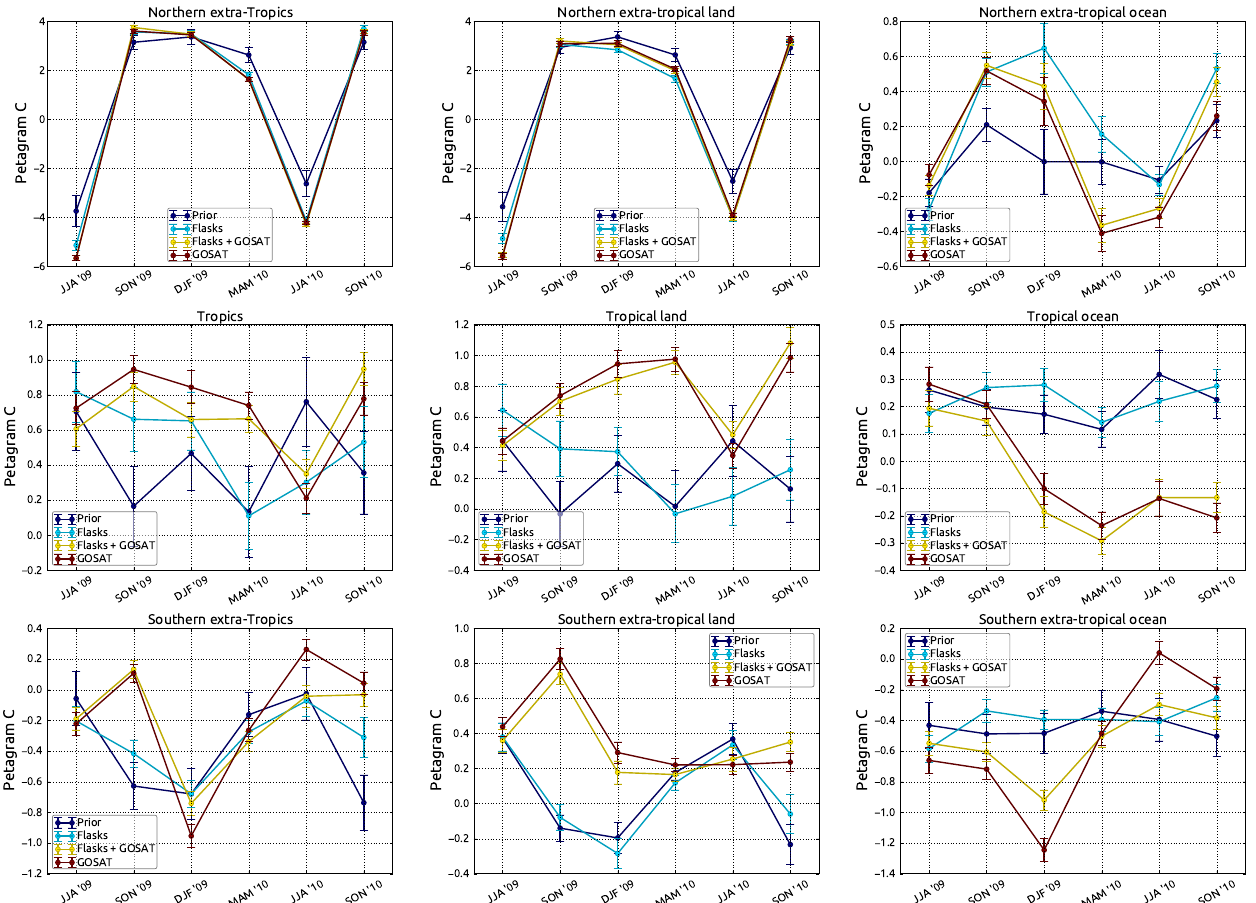
Fig. 10. Seasonal time series of the surface flux from the northern extra-tropics (top row), the tropics (middle row), and the southern extra- tropics (bottom row). The left column shows the total flux, the central column shows the terrestrial biosphere component, and the right column the oceanic contribution. In the northern extra-tropics, since the seasonal cycle imposed by the terrestrial biosphere is much larger than that imposed by the ocean, almost all of the northern extra-tropical seasonal signal comes from the land. In the tropics and southern extra-tropics, the magnitude of the seasonal variation of the oceanic source/sink is comparable to that of the land source/sink, although the phasing is different.